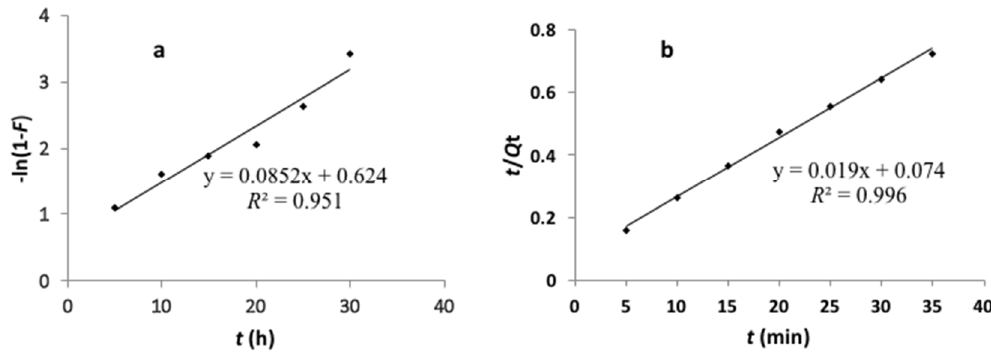
Figure 9. The linear plots of pseudo-first-order ( a ) and pseudo-second-order; ( b ) kinetic model.